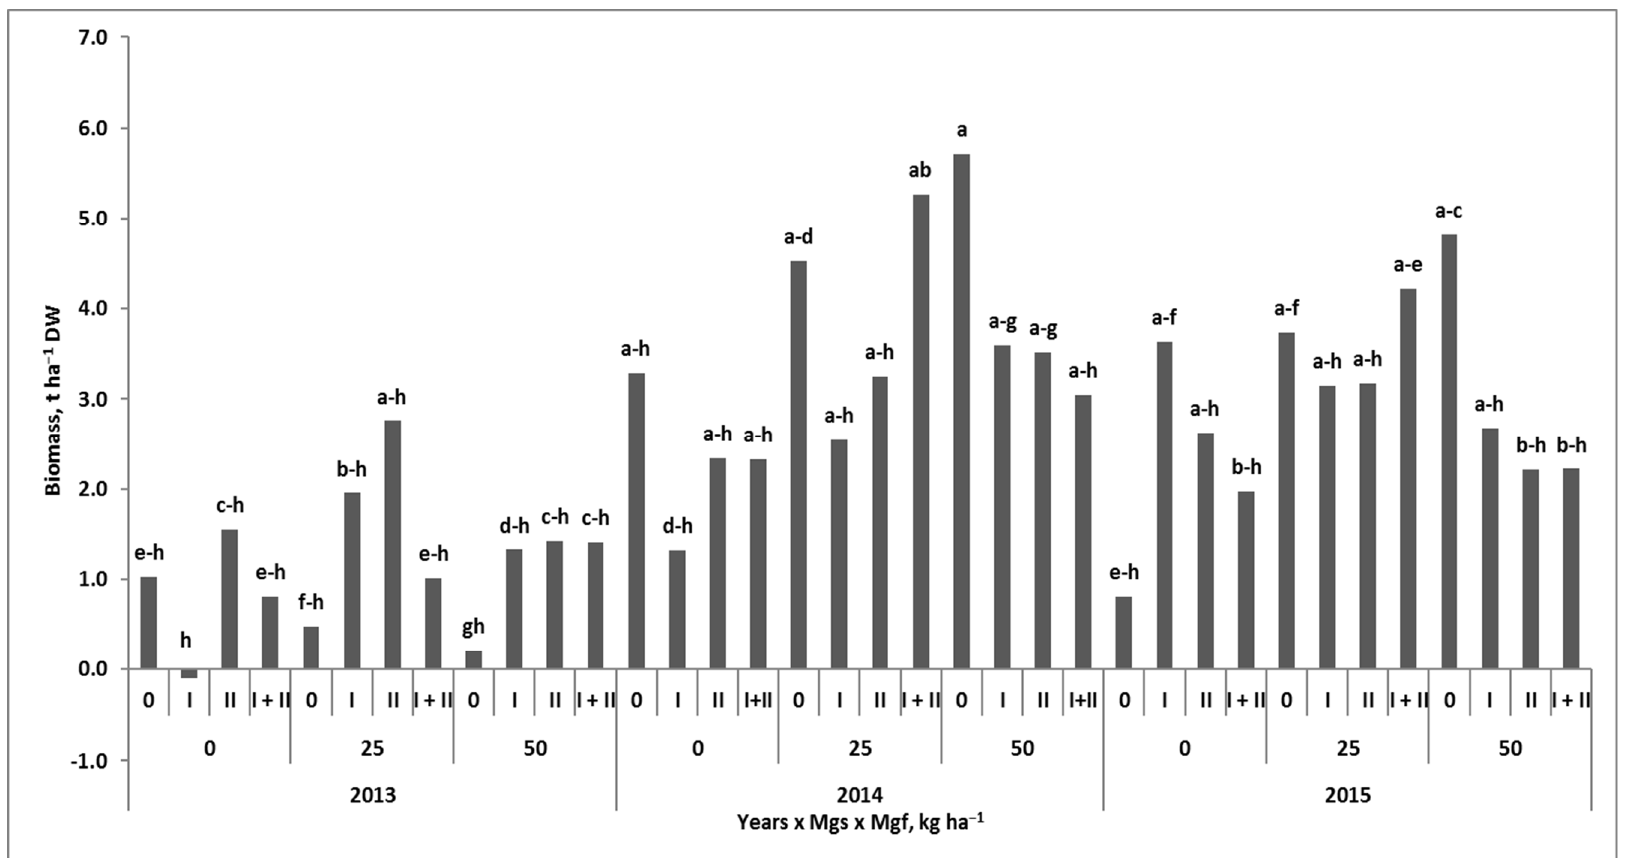
Figure 6. Effect of magnesium fertilization systems on the background of years on the remobilized dry matter of winter wheat in the grain-filling period. Similar letters mean a lack of significant differences using Tukey’s test. Legend: Mgs, Mgf—soil and foliar Mg fertilization systems, respectively; I—BBCH 30; II—BBCH 49/50.